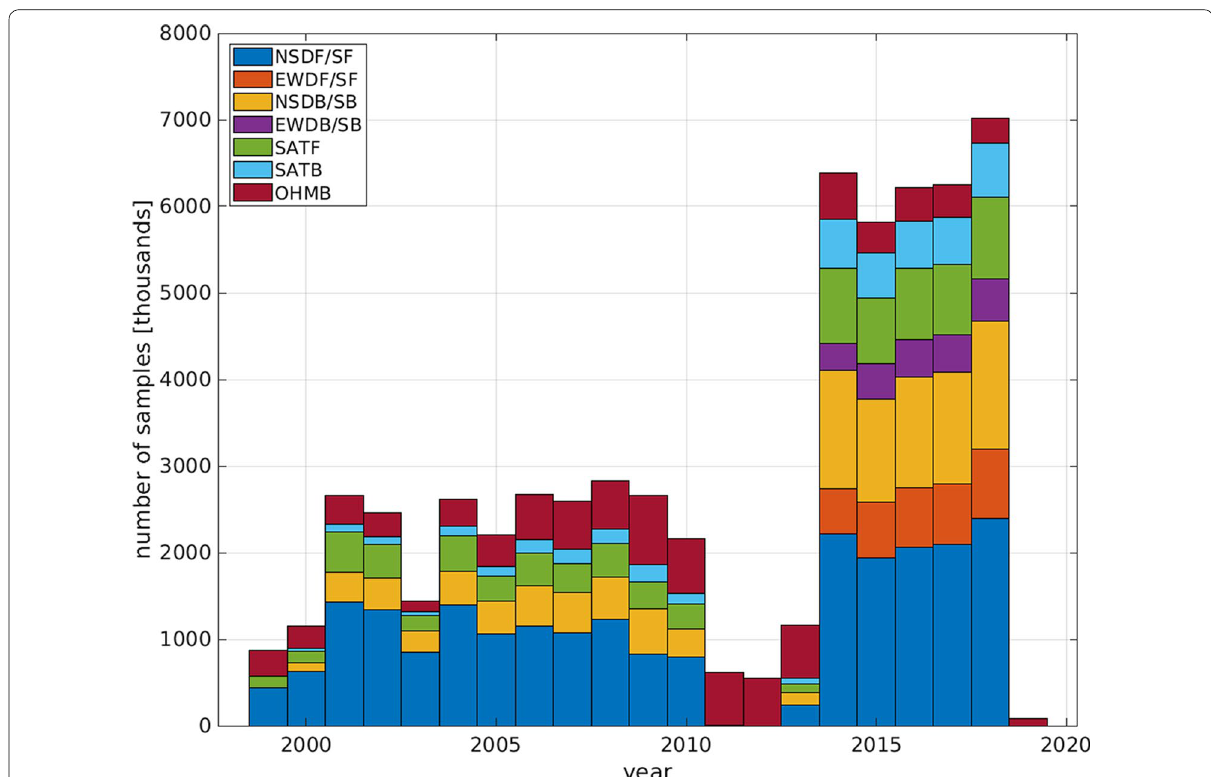
Fig. 1 Stacked bar graph of measurement counts per year used in deriving CM6, where “NS” and “EW” denote North–South along‑track and East– West across‑track, respectively, “DF/SF” and “DB/SB” denote scalar and vector differences and sums, respectively, and “SATF”, “SATB”, and “OHMB” denote satellite scalar, vector, and observatory vector measurements,